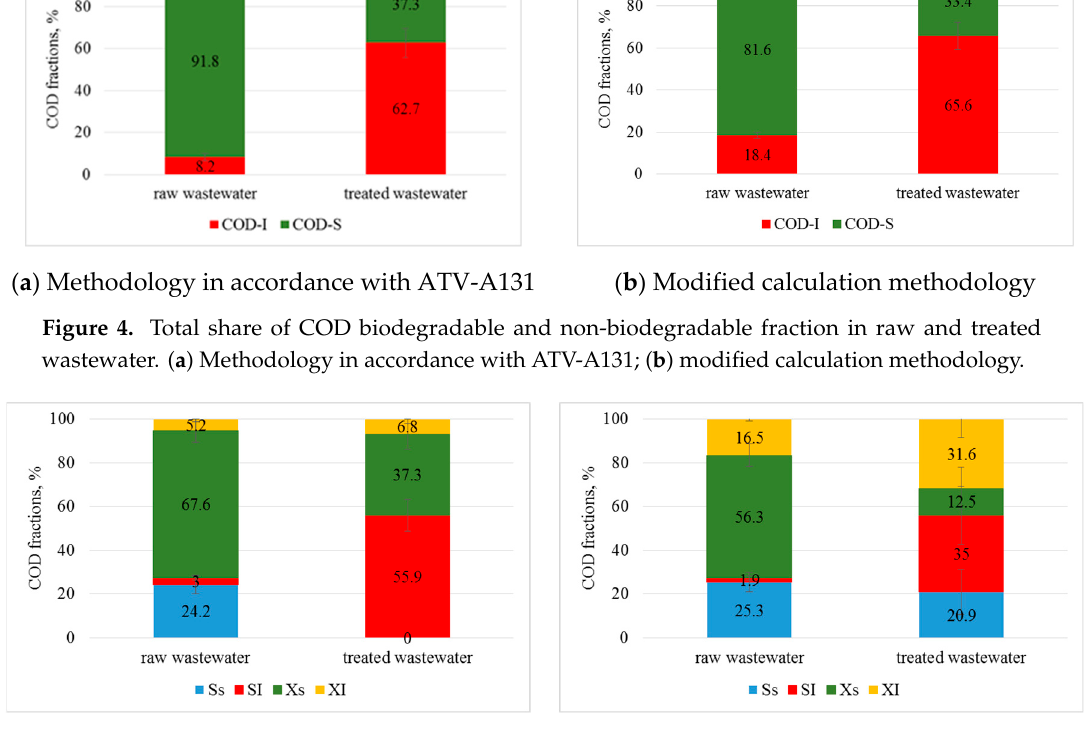
Figure 4. Total share of COD biodegradable and non-biodegradable fraction in raw and treated wastewater. ( a ) Methodology in accordance with ATV-A131; ( b ) modified calculation